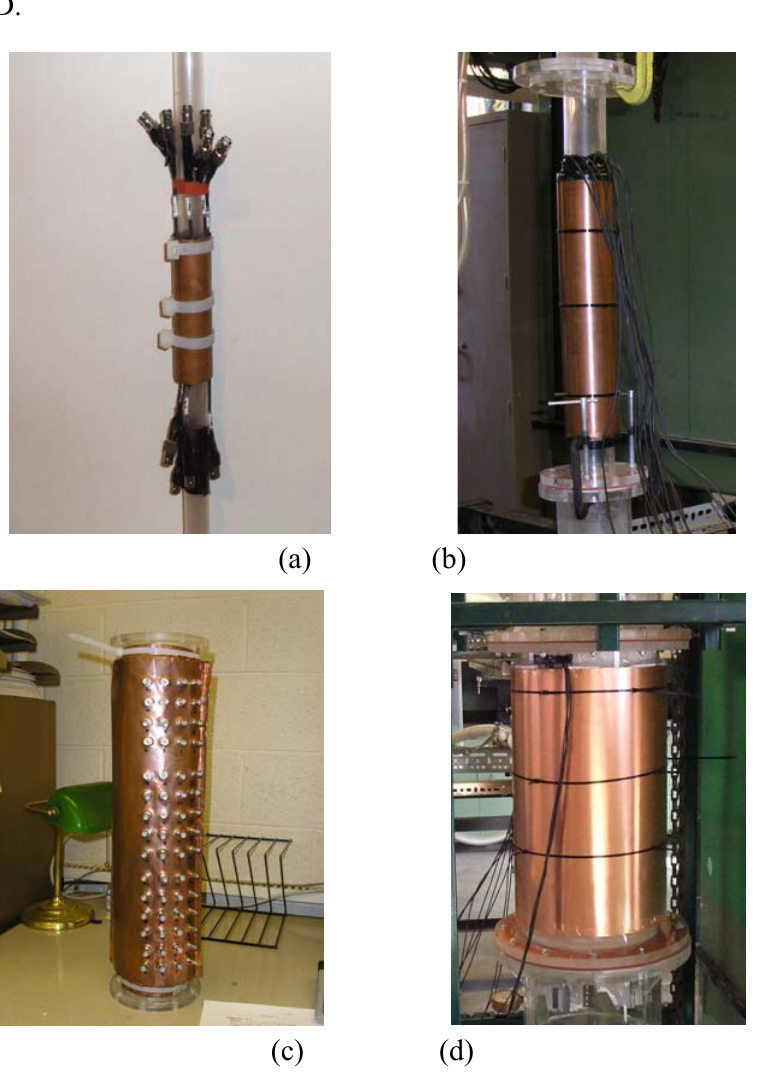
Figure 5. 60-in ECVT sensor: (a) sensor configuration; (b) photo of the 60-in sensor; (c) liquid concentration in the